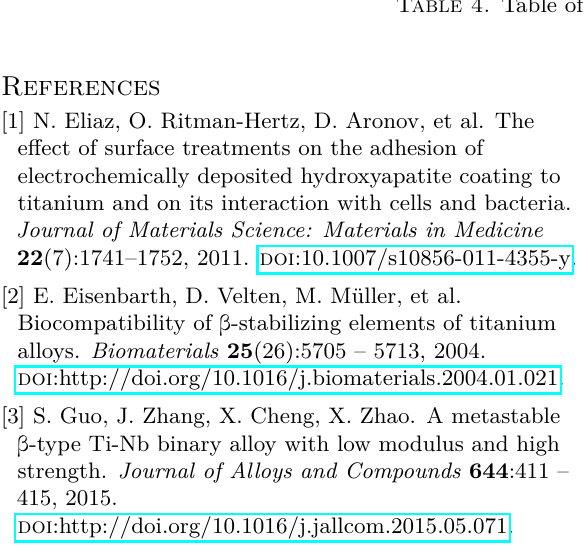
Table 4. Table of measured